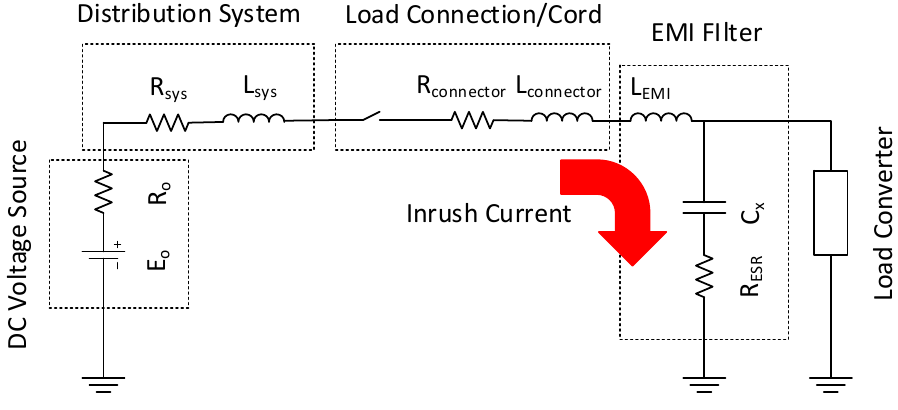
Figure 7. Sample DC distribution system with EMI filter for analysis of inrush